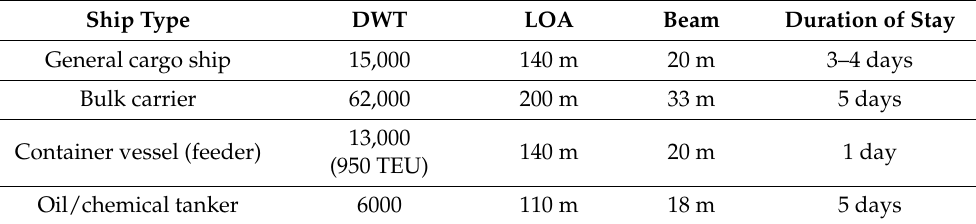
Table 6. Ship specifics according to the several criteria in the port of Split (maximum